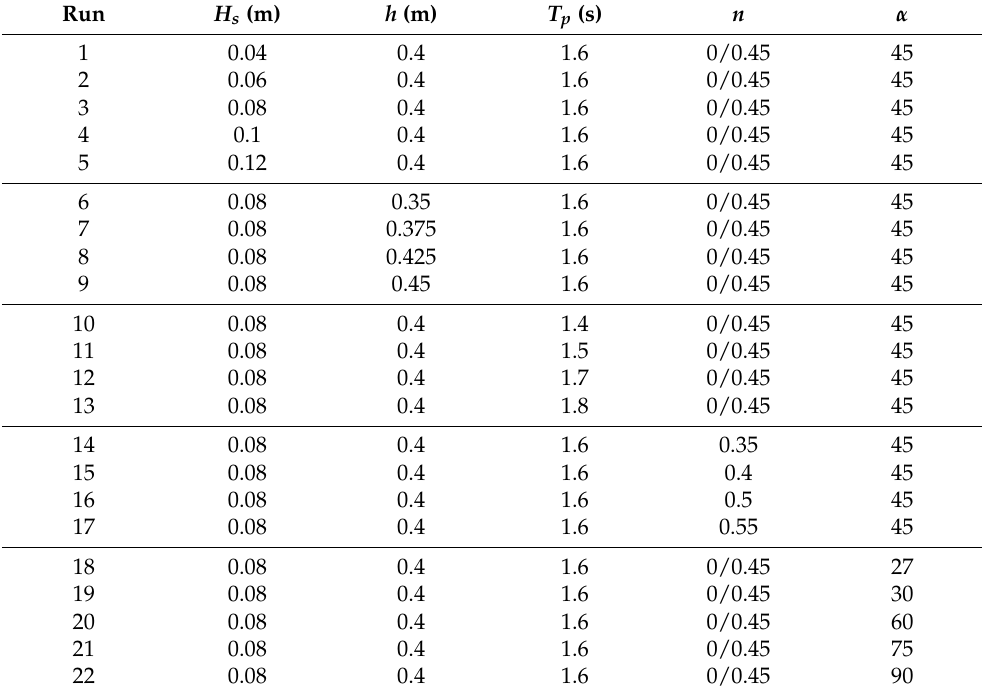
Figure 6. Computational layout. Table 2. Parameter setups for the computational